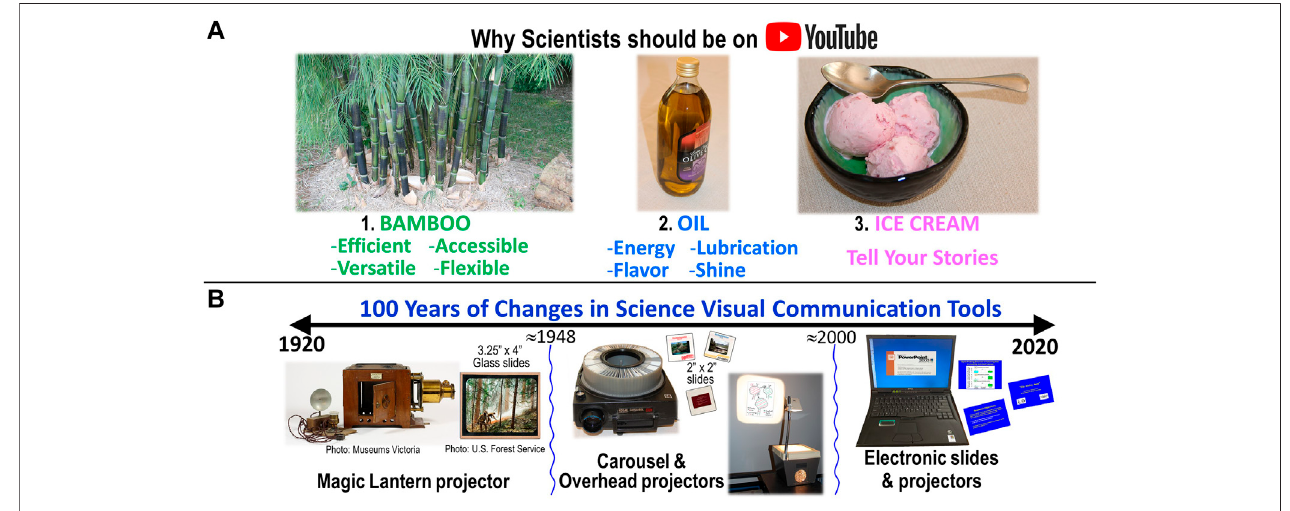
FIGURE 1 | Three memorable items to help remind scientists why Do-It-Yourself YouTube videos are important for science communication (A) , and three major changes in science communications tools from 1920 to 2020 (B) .